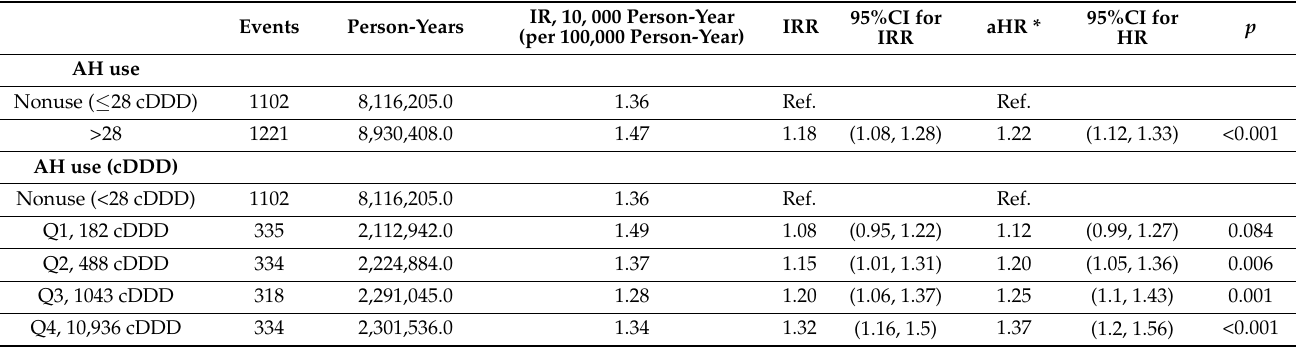
Table 3. IRRs and aHRs for ESCC.